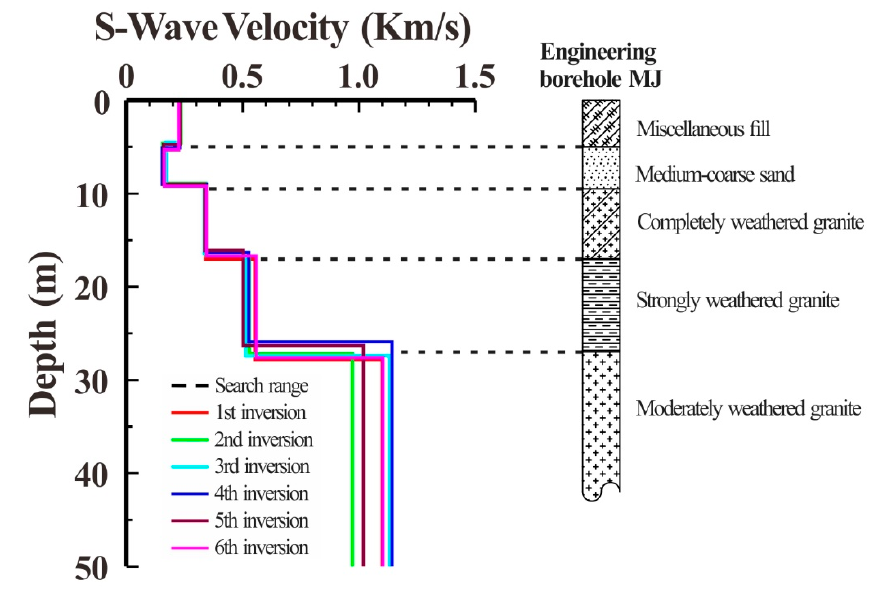
Figure 13. Comparison between inversion results and borehole histogram.